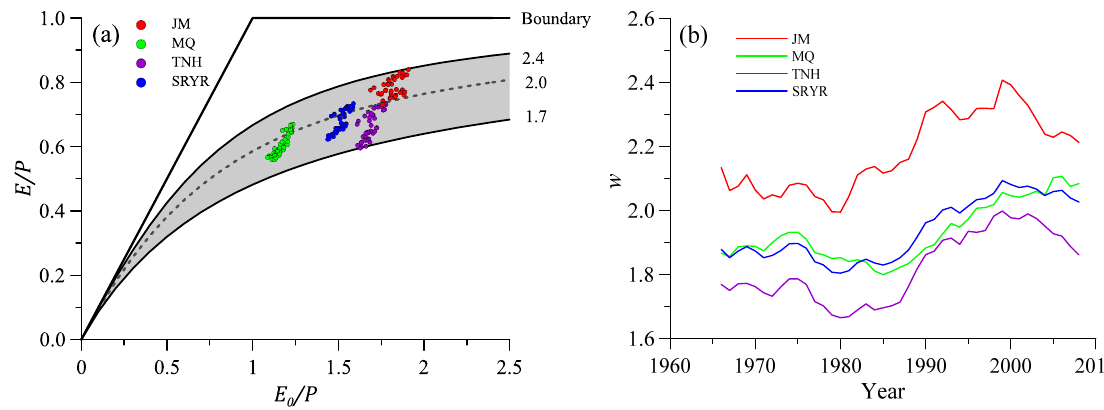
Figure 5. Plots of the moving average water balance in the Budyko space: ( a ) time‐varying values of the catchment parameter ( w ) in Fu’s formula, and ( b ) for the three sub‐basins. In ( a ), 2.4, 2.0, and 1.7 refer to the w value for the three types of curves.